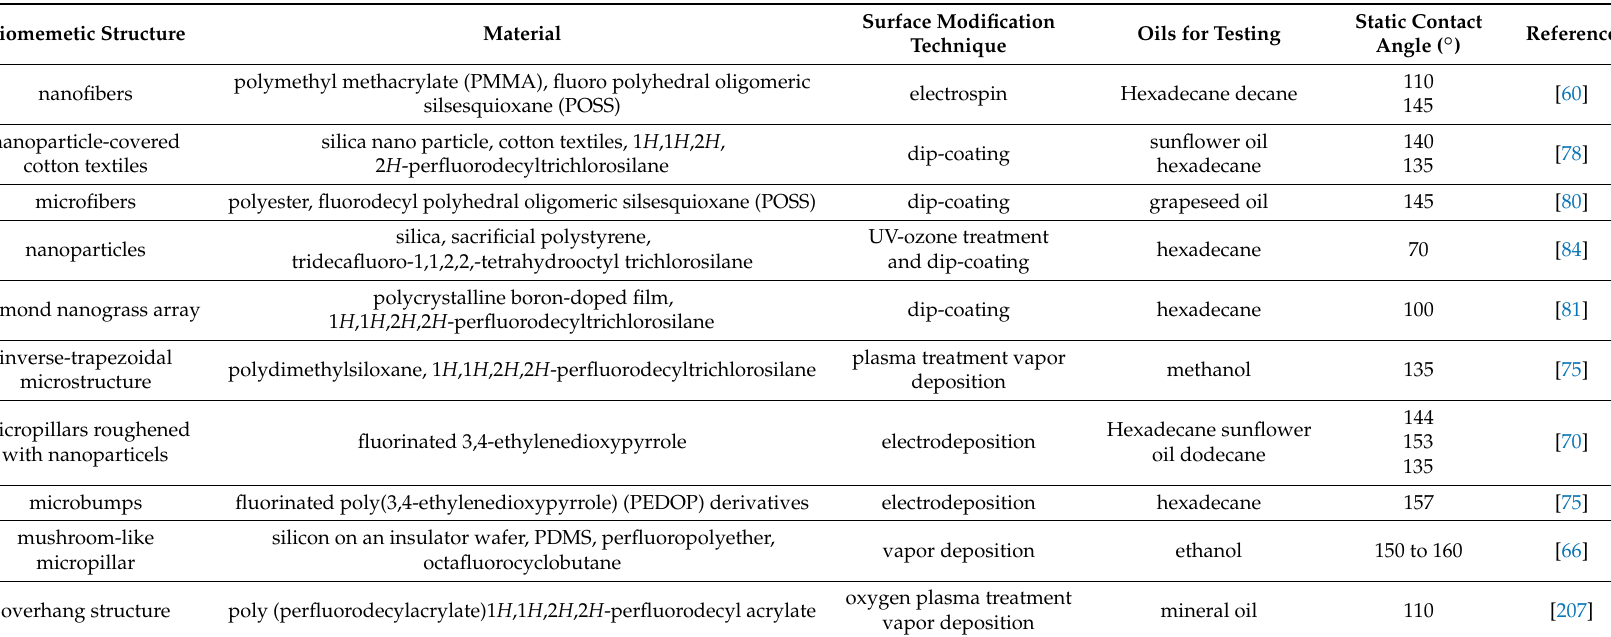
Table 3. List of bio-inspired structures, materials, surface modification techniques for the fabrication of the bio-mimicked oleophobic materials and the oil(s) contact